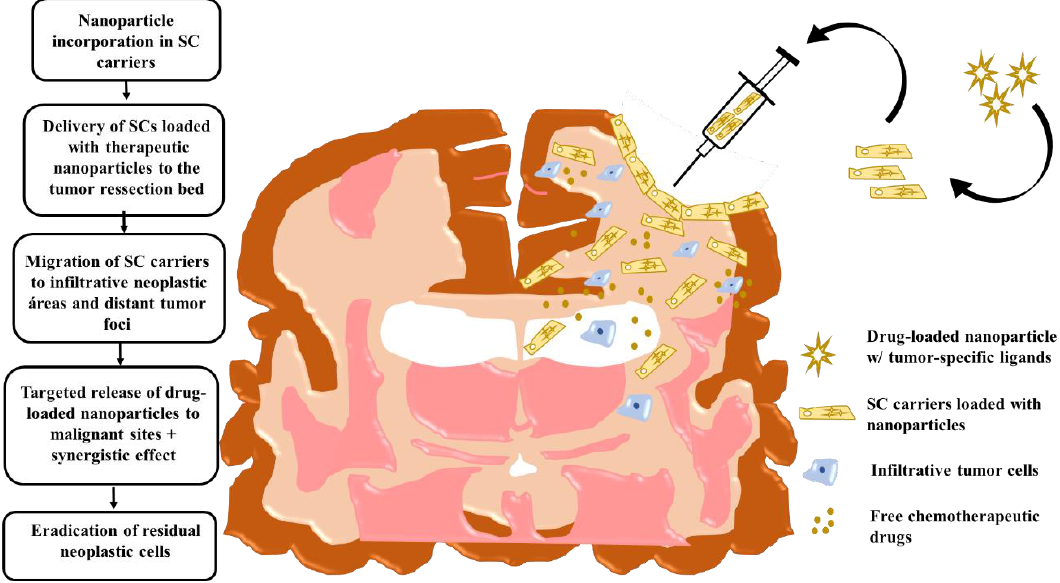
Figure 5. Intraoperative transplantation of stem cells carrying drug-loaded nanoparticles into the human brain post-tumor resection. Chronological order of the events that take place post-surgical transplantation. Here, stem-cell carrier tumor-tropic migration results in a targeted drug release in infiltrative tumor zones. Modified cell carriers contribute to the local toxic effects caused by the drug-loaded system in neoplastic areas. Stem-cell immunosuppressive properties hide loaded nanocarriers from the host-immune system and facilitate targeted anti-glioma therapy. Adapted with some modification from [70] , Auffinger et al., 2013.